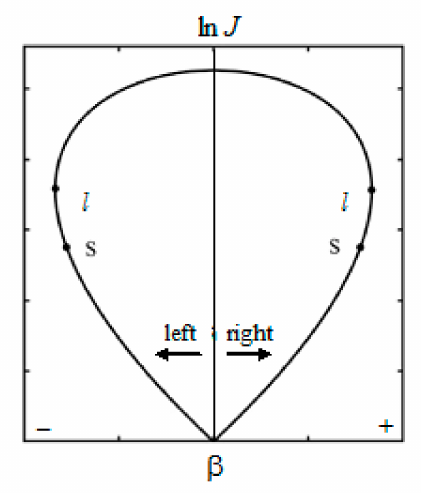
Figure 3. Shock polar (Busemann curve). Point l corresponds to the shock with the maximum pos- sible flow turning angle, and point s is the sonic point.